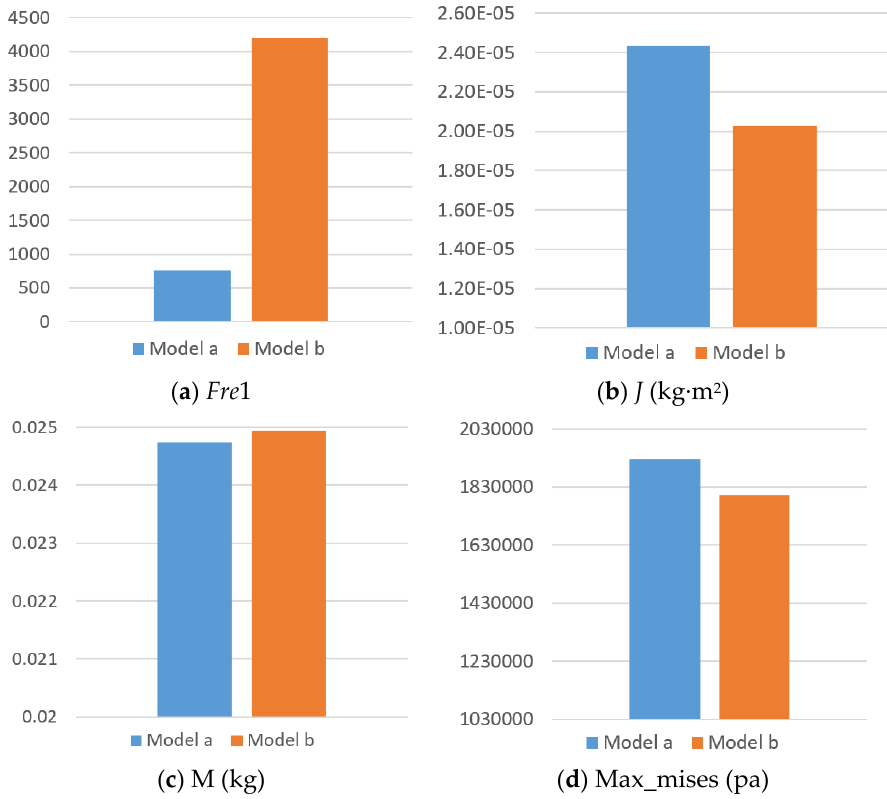
Figure 6. Comparison of the optimisation models.